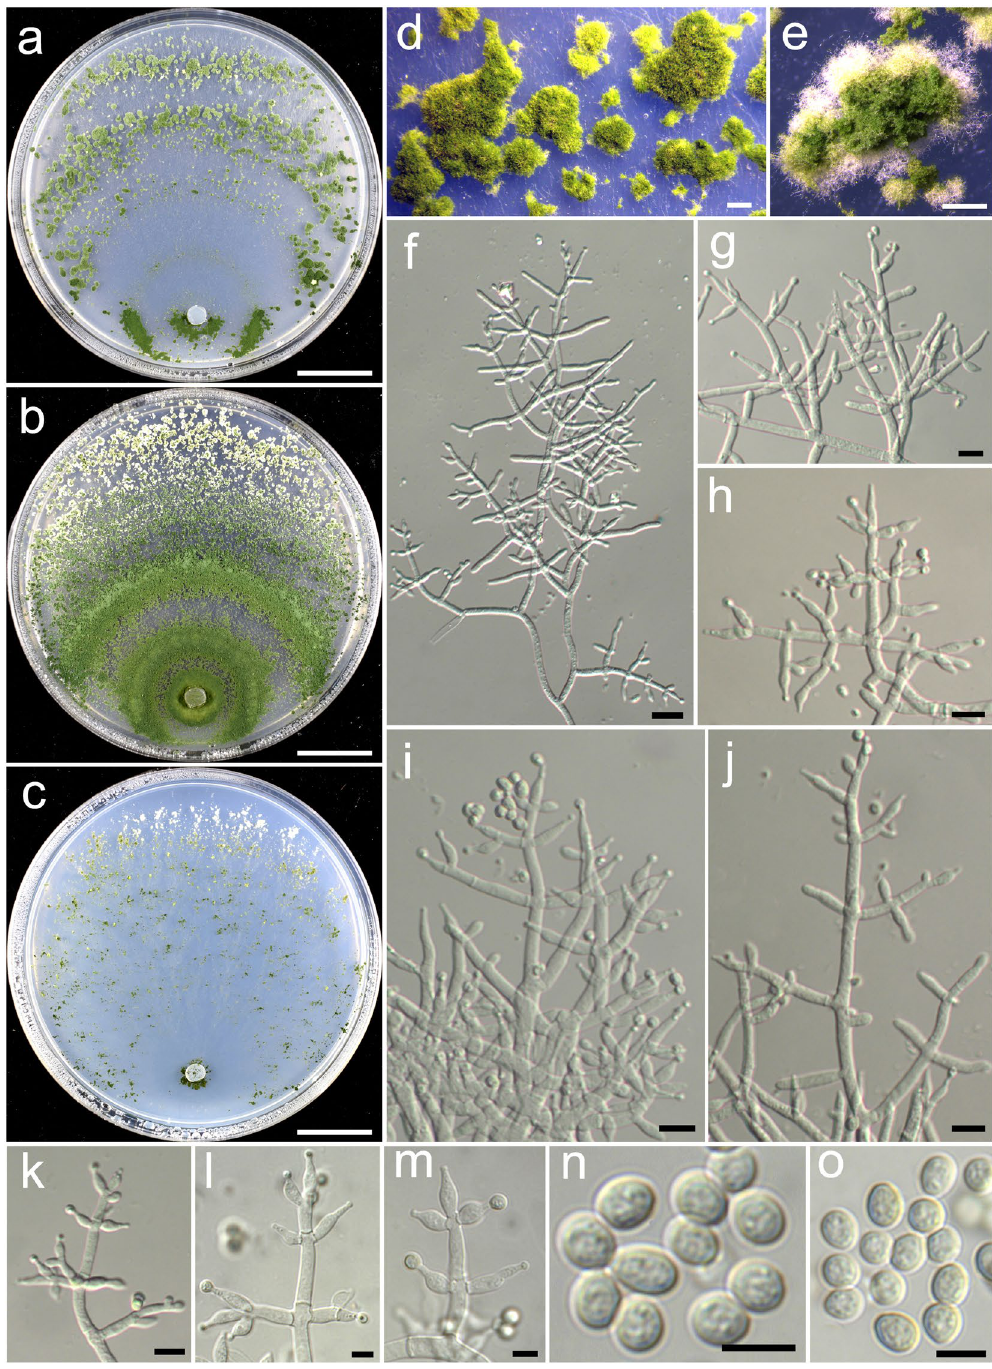
Figure 12. Trichoderma hengshanicum (HMAS 248852). ( a–c ) Cultures at 25 °C (a. on CMD, 7 d; b. on PDA, 7 d; c. on SNA, 12 d); ( d–e ) Conidial pustules (d. CMD, 7d; e. PDA, 7 d); ( f–m ) Conidiophores and phialides (PDA, 4 d); ( n–o ) Conidia (PDA, 4 d). Bars: a–c = 20 mm. d–e = 400 μ m. f = 20 μ m. g–k = 10 μ m. l–o = 5 μ